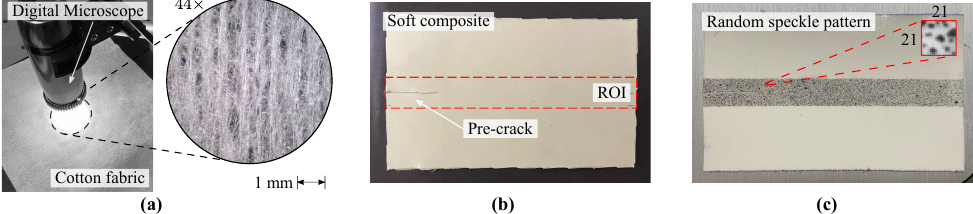
Figure 1. ( a ) Structure of the cotton knit fabric, ( b ) manufactured soft composite with depicted Region